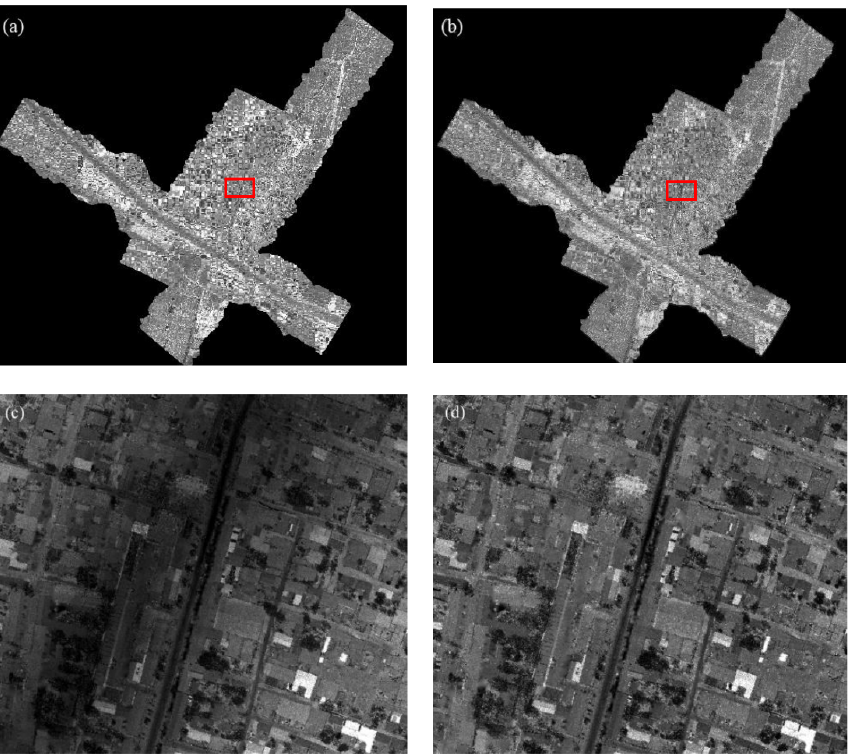
Figure 7. ( a ) The original intensity data (the reflectance); ( b ) the corrected intensity data by elimi-